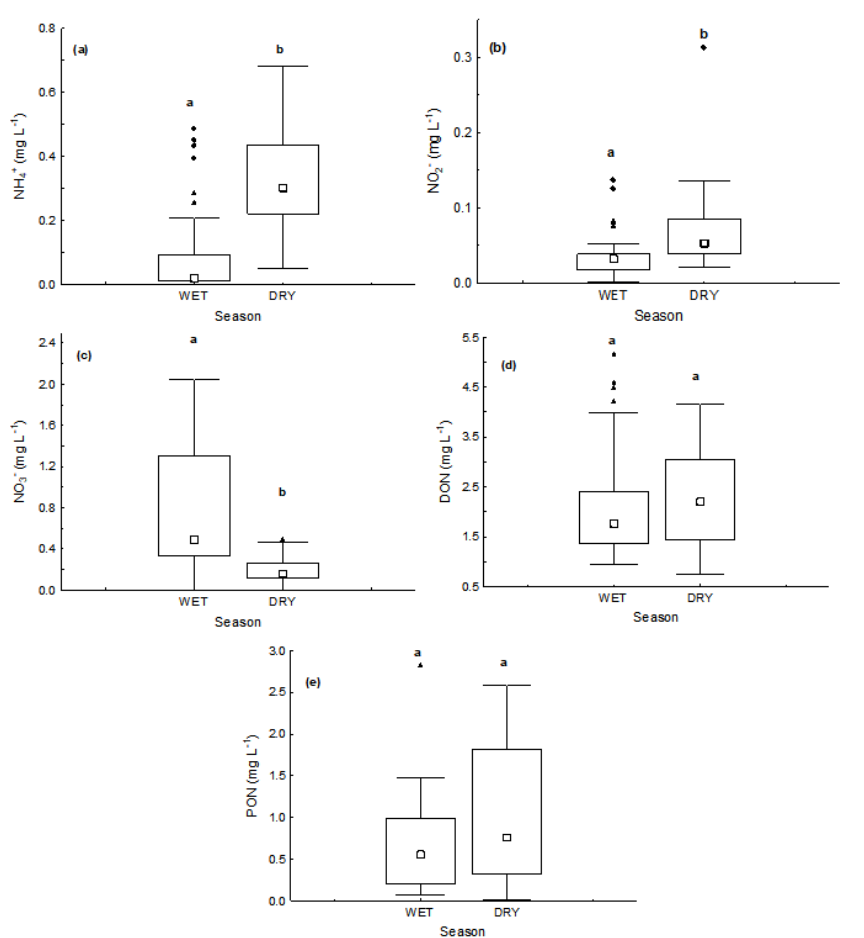
Figure 5. Box and whisker plots of seasonal variation of water quality variables: ( a ) NH 4+ , ( b ) NO 2 - , ( c ) NO 3 - ( d ) DON, and ( e ) PON. Small white squares represent median values, boxes represent the interquartile range, range bars show the maximum and minimum values, black triangles represent the extremes and black diamonds the outliers. Different letters (a and b) over box plots indicate a significant difference (Mann-Whitney U test, p < 0.05).